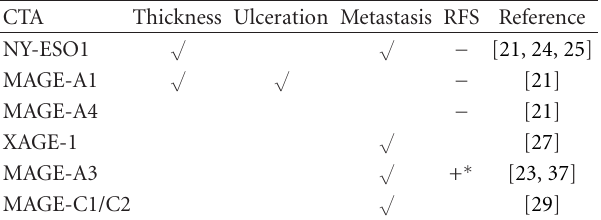
Table 2: Cancer testis gene and associated melanoma prognostic